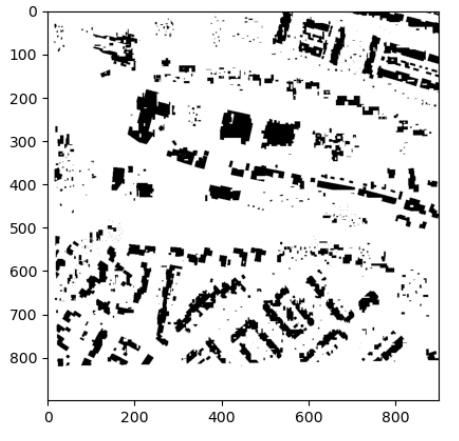
Figure 6. Classified